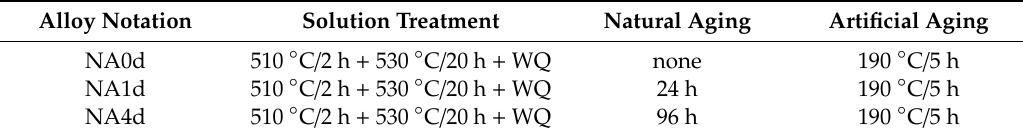
Table 2. Heat treatment cycles for preparation of as-cast